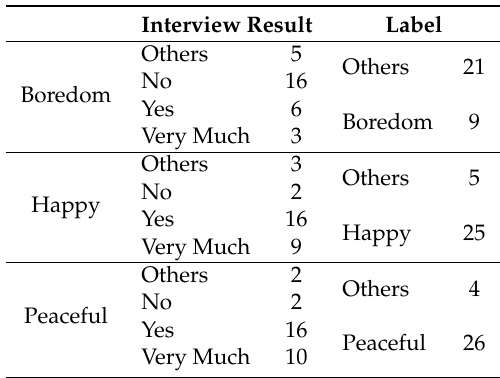
Table 6. Interview results and label distribution.